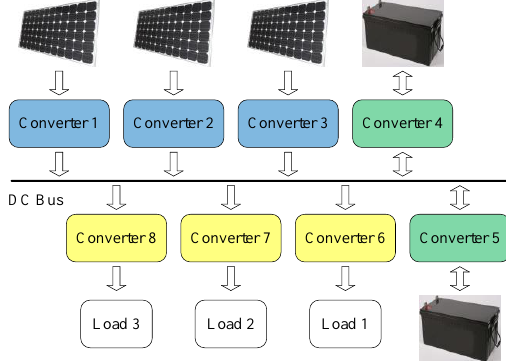
Figure 19. Schematic diagram of the simulated standalone DC